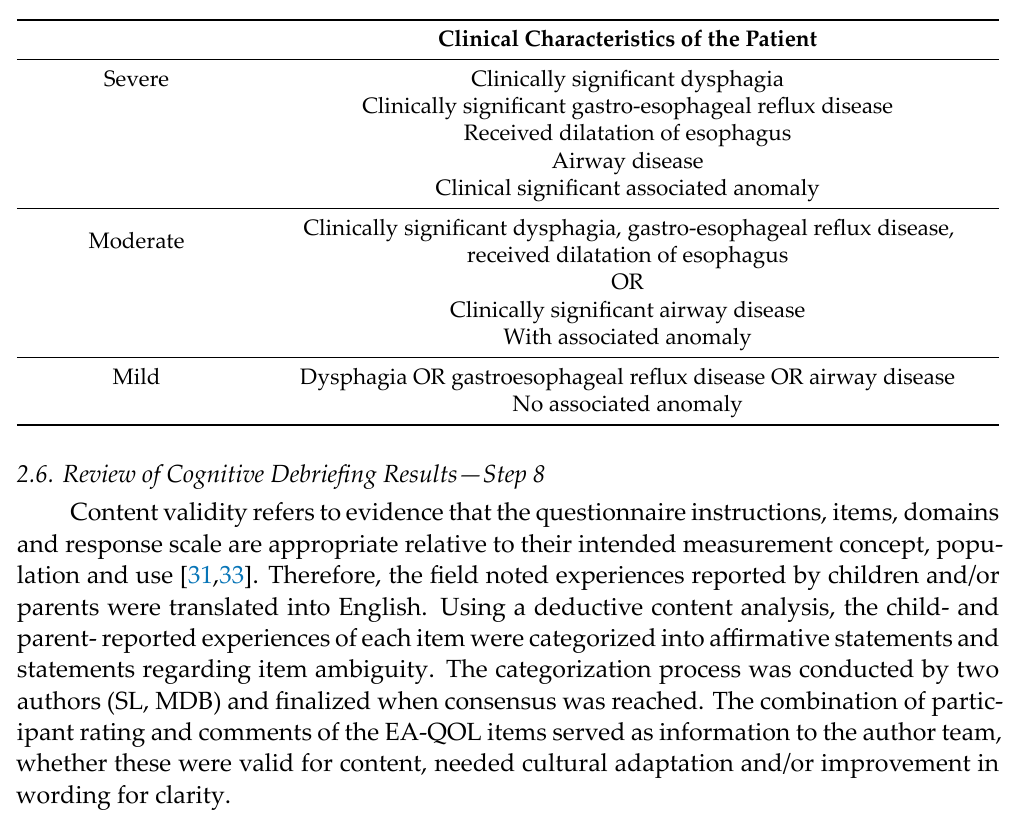
Table 1. Severity of